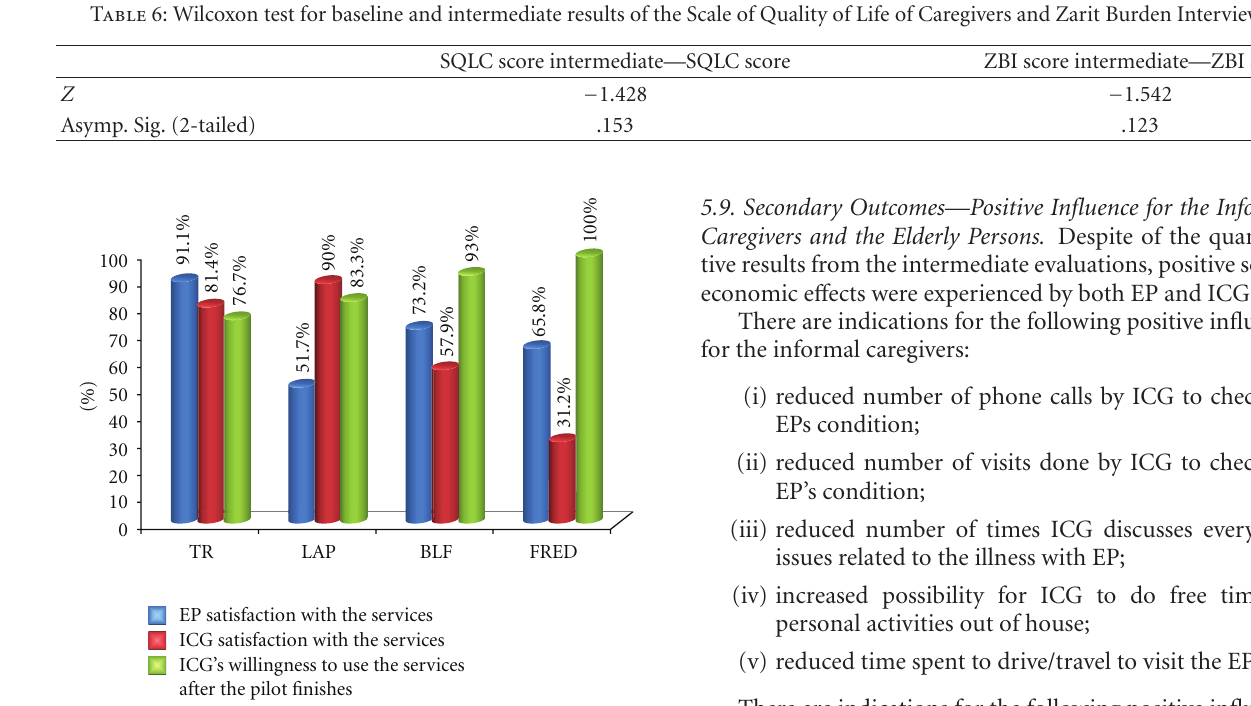
Figure 5: User satisfaction results from the intermediate evaluation—overall for EP and ICG subjects (intervention